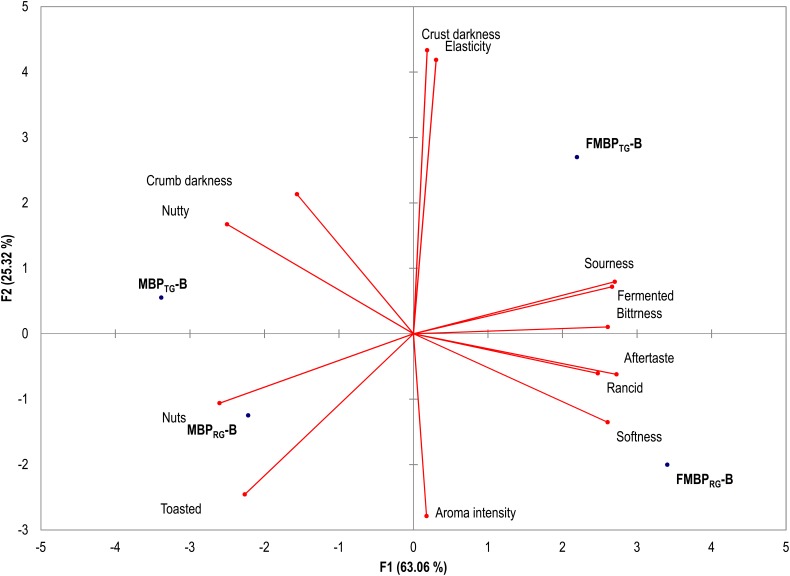
Principal Components Analysis (PCA) based on the sensory attributes of breads: MBPRG-B, containing unfermented mixture of raw germ and bran (MBPRG,12.5%, wt/wt); MBPTG-B, containing unfermented mixture of heat-treated germ and bran (MBPTG, 12.5%, wt/wt); FMBPRG-B, containing fermented mixture of raw germ and bran (FMBPRG, 25% wt/wt); FMBPTG-B, containing fermented mixture of heat-treated germ and bran (FMBPTG, 25% wt/wt). Fermented milling by-products doughs (FMBPRG and FMBPTG) (DY 200) were fermented with Lactobacillus plantarum T6B10 and Weissella confusa BAN8 at 30°C for 24 h. Doughs for breadmaking had DY 180.